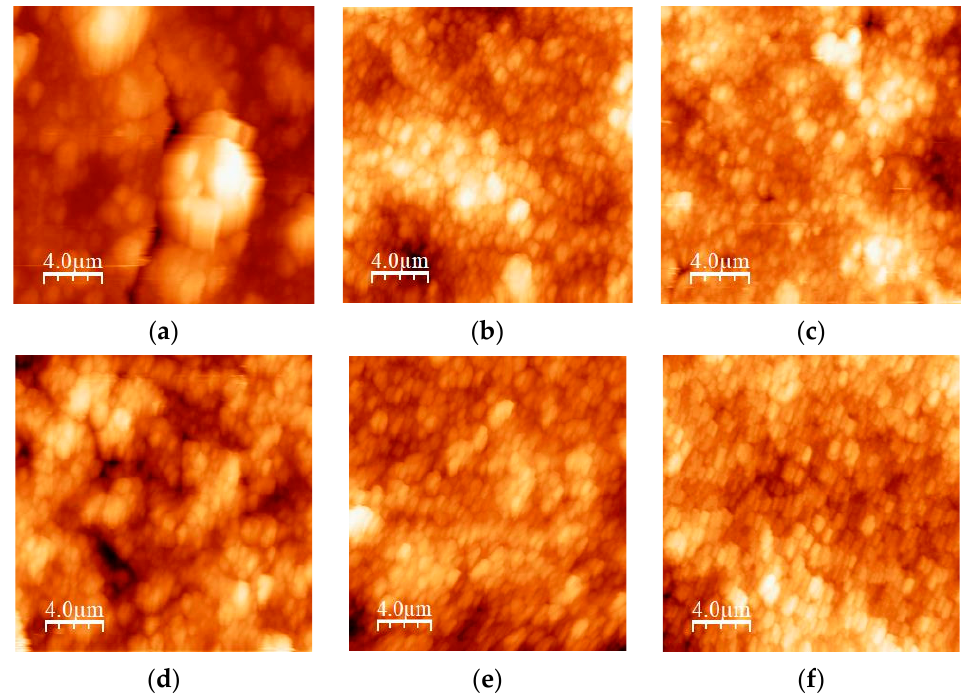
Figure 9. 2D AFM images of: ( a ) TiCe-0.8:0.2-40; ( b ) TiCe-0.2:0.8-40; ( c ) TiCe-0.5:0.5-40; ( d ) TiCe- 0.8:0.2-100; ( e ) TiCe-0.2:0.8-100; ( f ) TiCe-0.5:0.5-100. Table 5. Roughness parameters estimated from AFM measurements.